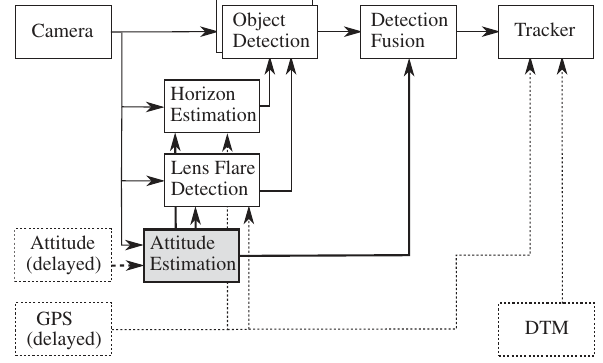
Figure 10: Visualization of the tracks from the surface of the tracking sphere with disabled and enabled attitude filter for Sce- nario P . If the delayed attitude measurements are directly used, the detections are projected to wrong positions on the unit sphere and the tracker fails to create a consistent